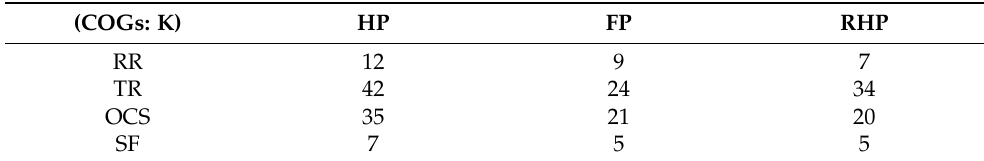
Table 1. K-category (transcriptional processes) classification of the three groups, based on the P2RP tool. RR are response regulators; TR, transcriptional regulators; OCS, one-component systems and SF, sigma factors.